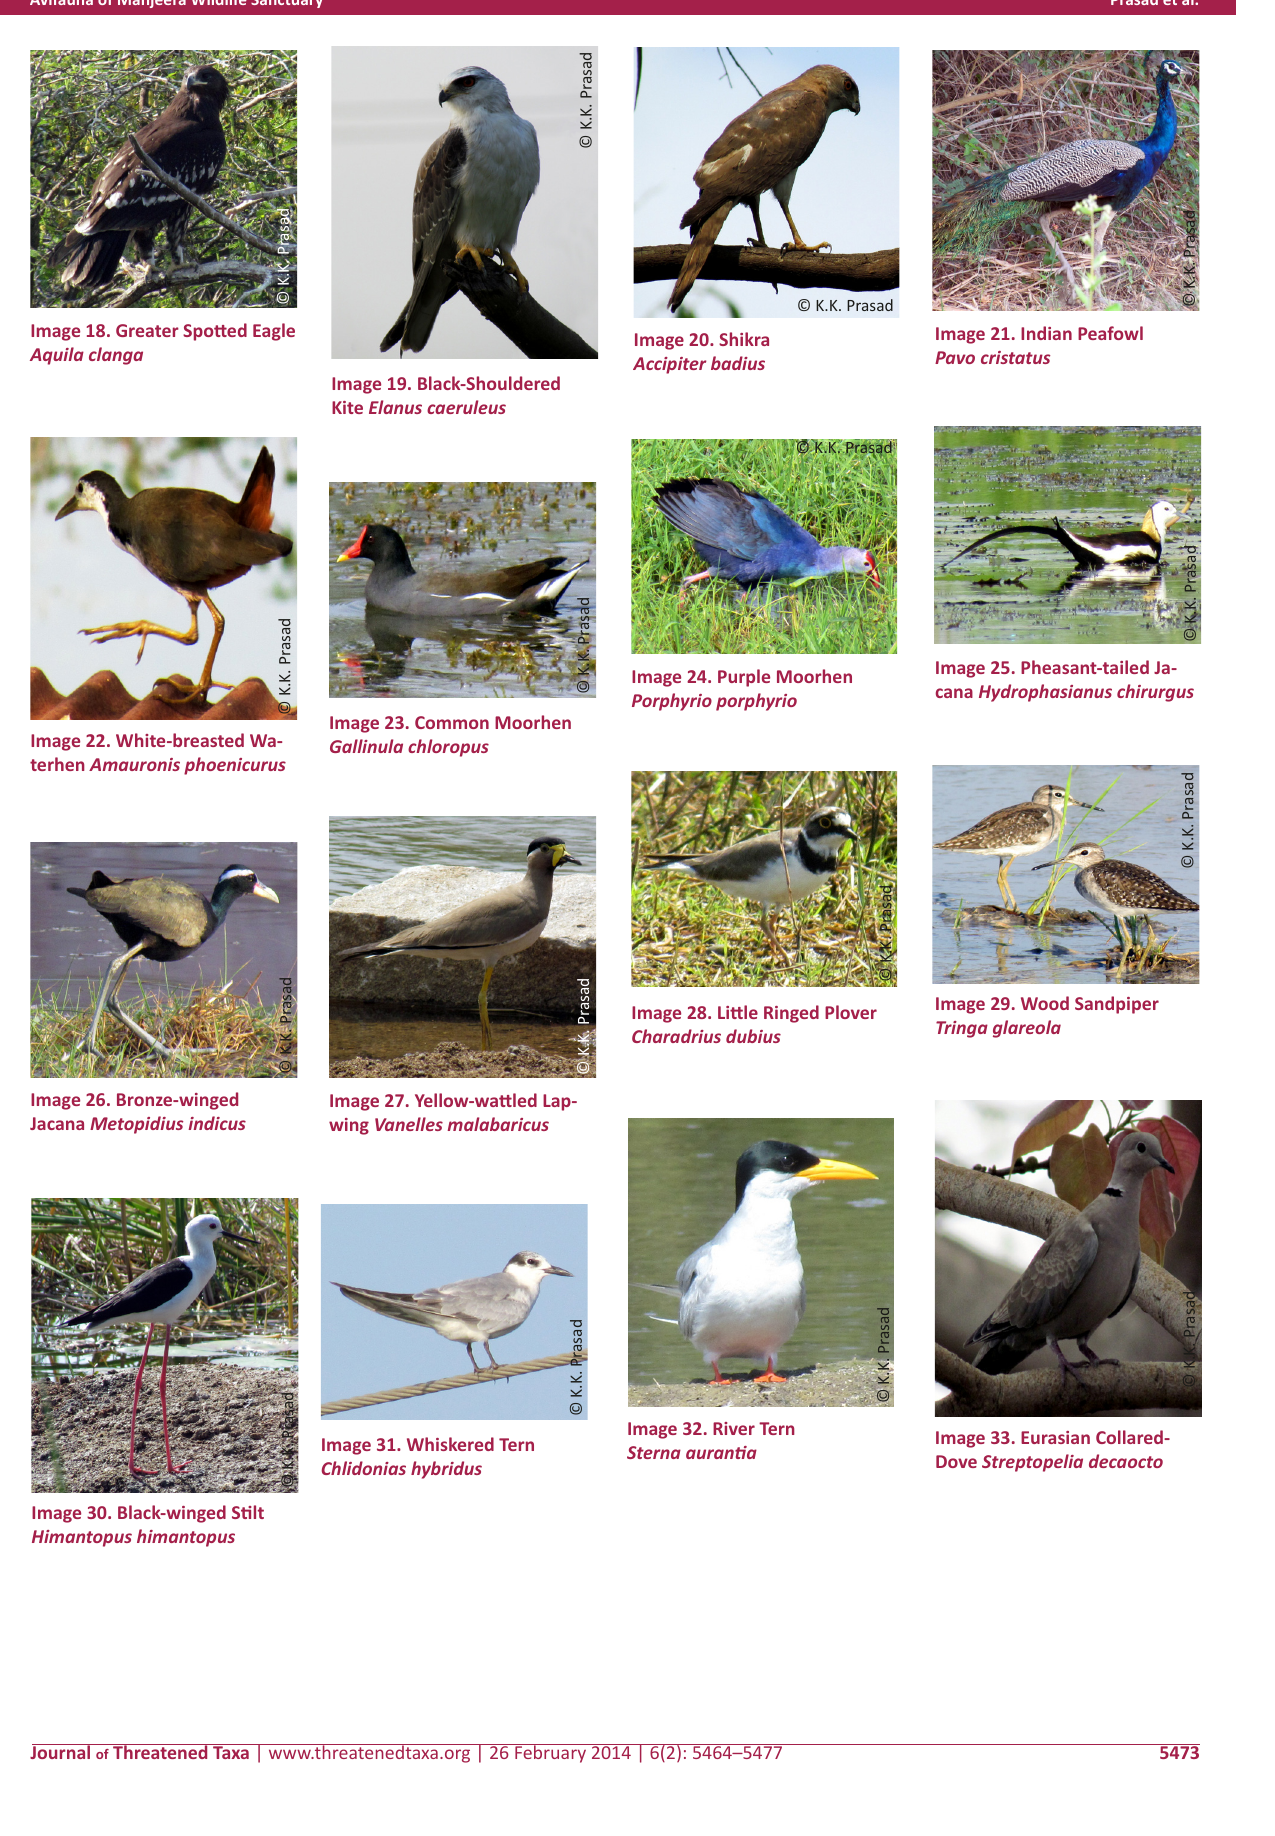
Image 30. Black-winged Stilt Himantopus himantopus